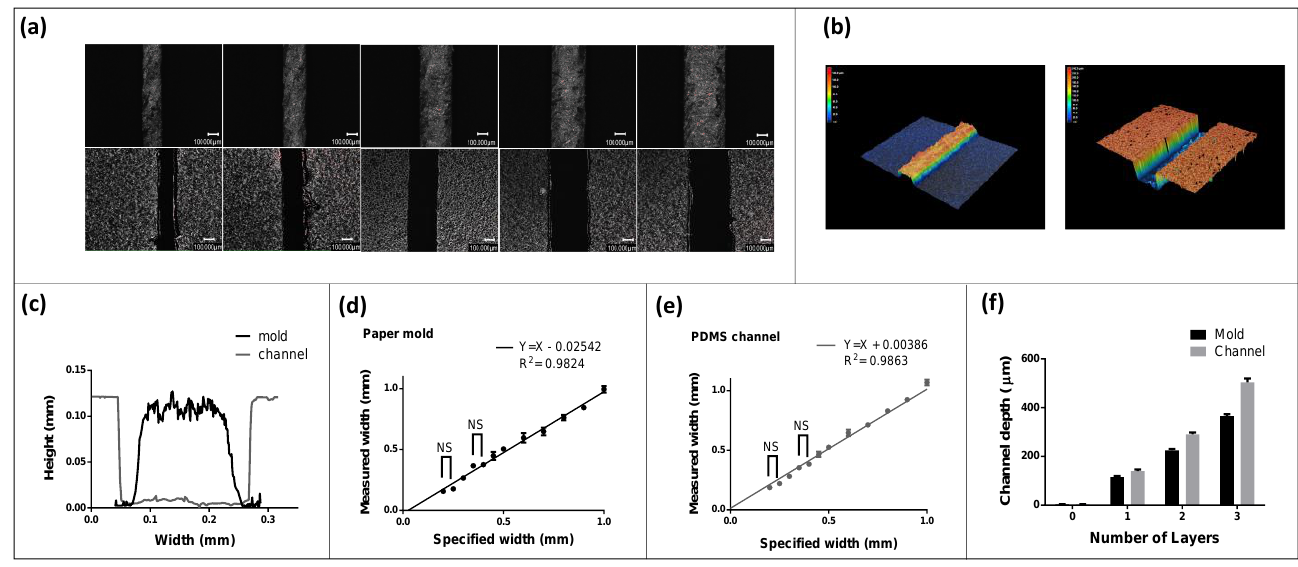
Figure 4. Characterization of liquid based micromolding process. ( a ) Several brightfield microscopic images showing the mold and the casted channel for different widths. The smallest channel width that could be replicated reliably was found to be ~175 microns. The scale bar represents 100 µm on each image. ( b ) 3D laser scan showing the paper mold and the corresponding molded microchannel in silicone. ( c ) Cross-sectional profile of the mold and the channel showing that the channel width is dependent on the amount of water added. ( d ) Plot showing measured width vs. specified width for the paper mold. A positive systemic error results from the cutting operation where the material is lost. ( e ) Plot showing measured width vs. specified width for the casted PDMS microfluidic channel. NS represent non-significant groups for which p > 0.05 whereas rest of the measurements were found statistically significant based on unpaired t -test and yielded a p < 0.001. ( f ) The channel depth can be controlled by stacking more paper layers.